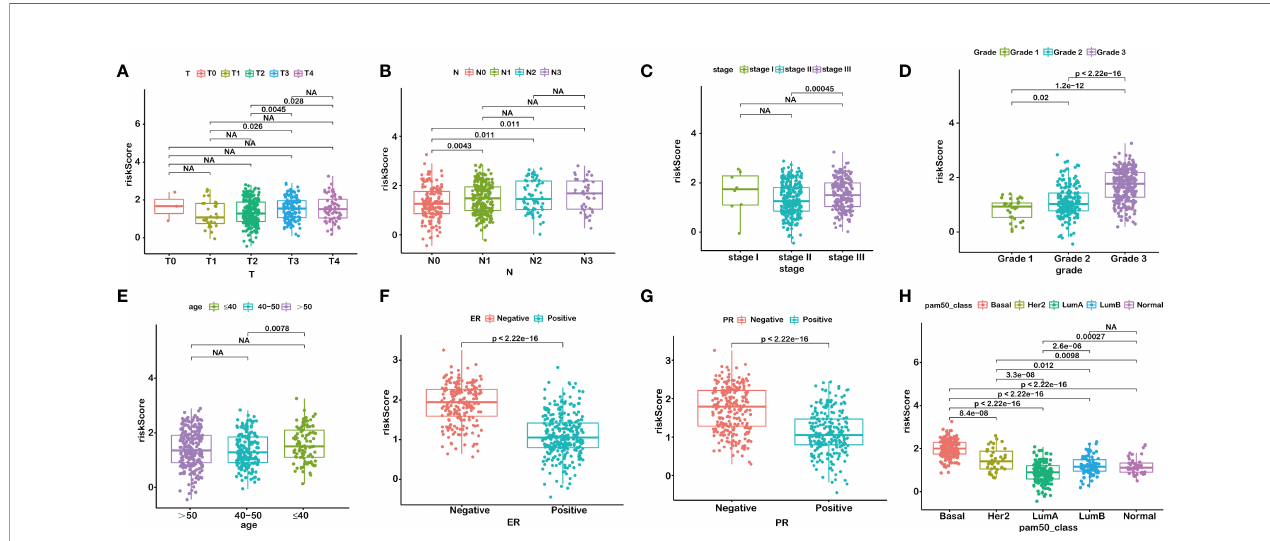
FIGURE 3 | RiskScore is correlated with clinicopathological features of BRCA. T stage (A) , N stage (B) , AJCC-stage (C) , Grade (D) , age (E) , ER status (F) , PR status (G) , PAM50 subtypes (H) . NA,